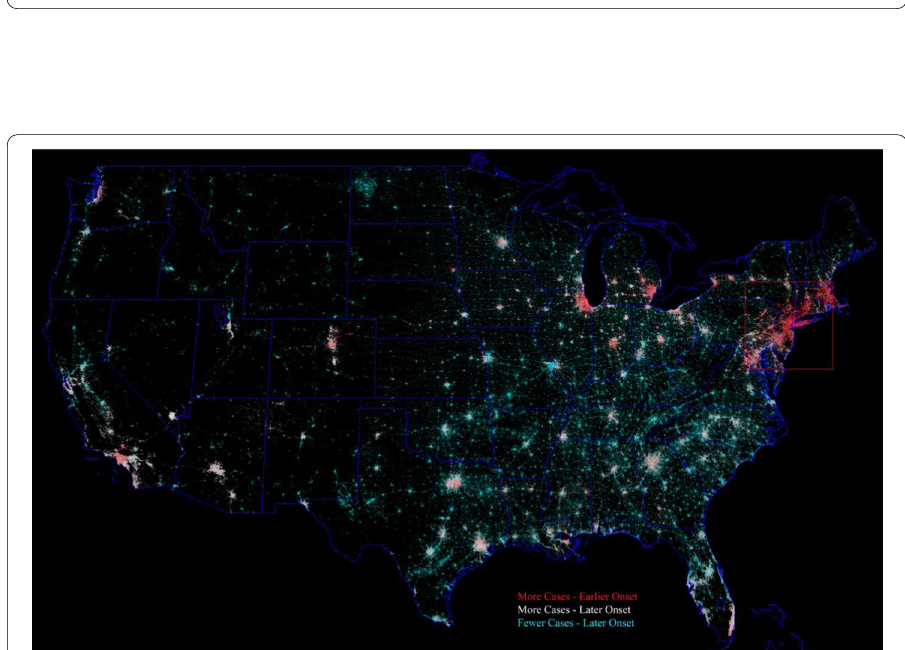
Fig. 13 Geographic distribution of number and timing of confirmed cases of COVID-19 for the USA. Principal component loadings from Fig. 12 projected onto spatial network of lighted development show stark contrast between the most distinct temporal trajectories. The Northeast Corridor and Great Lakes Industrial Belt components contrast strongly with larger network components in the south and west and smaller components throughout the country. Note the gradient in case number and timing within the Northeast Corridor component (red